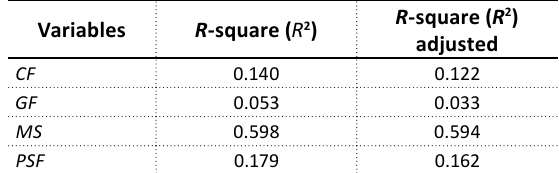
Table 5. Coefficient of determination ( R 2 )